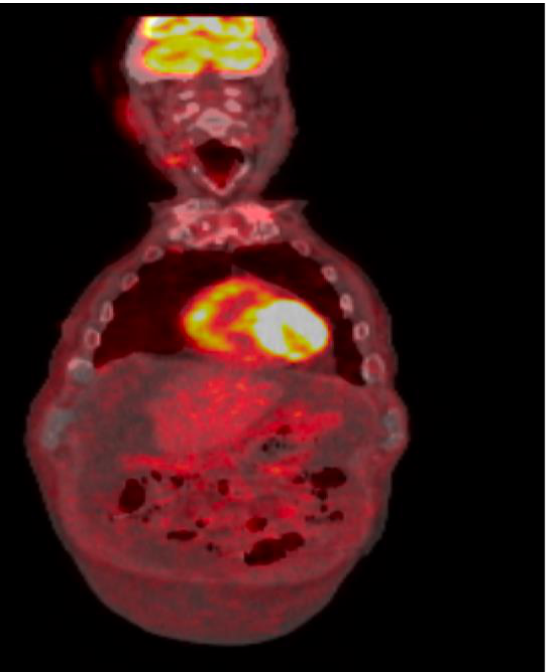
Figure 4. FDG-PET/CT: Large volume ascites with omental caking, the caking exhibited increased FDG activity with an SUV max of 3.1.